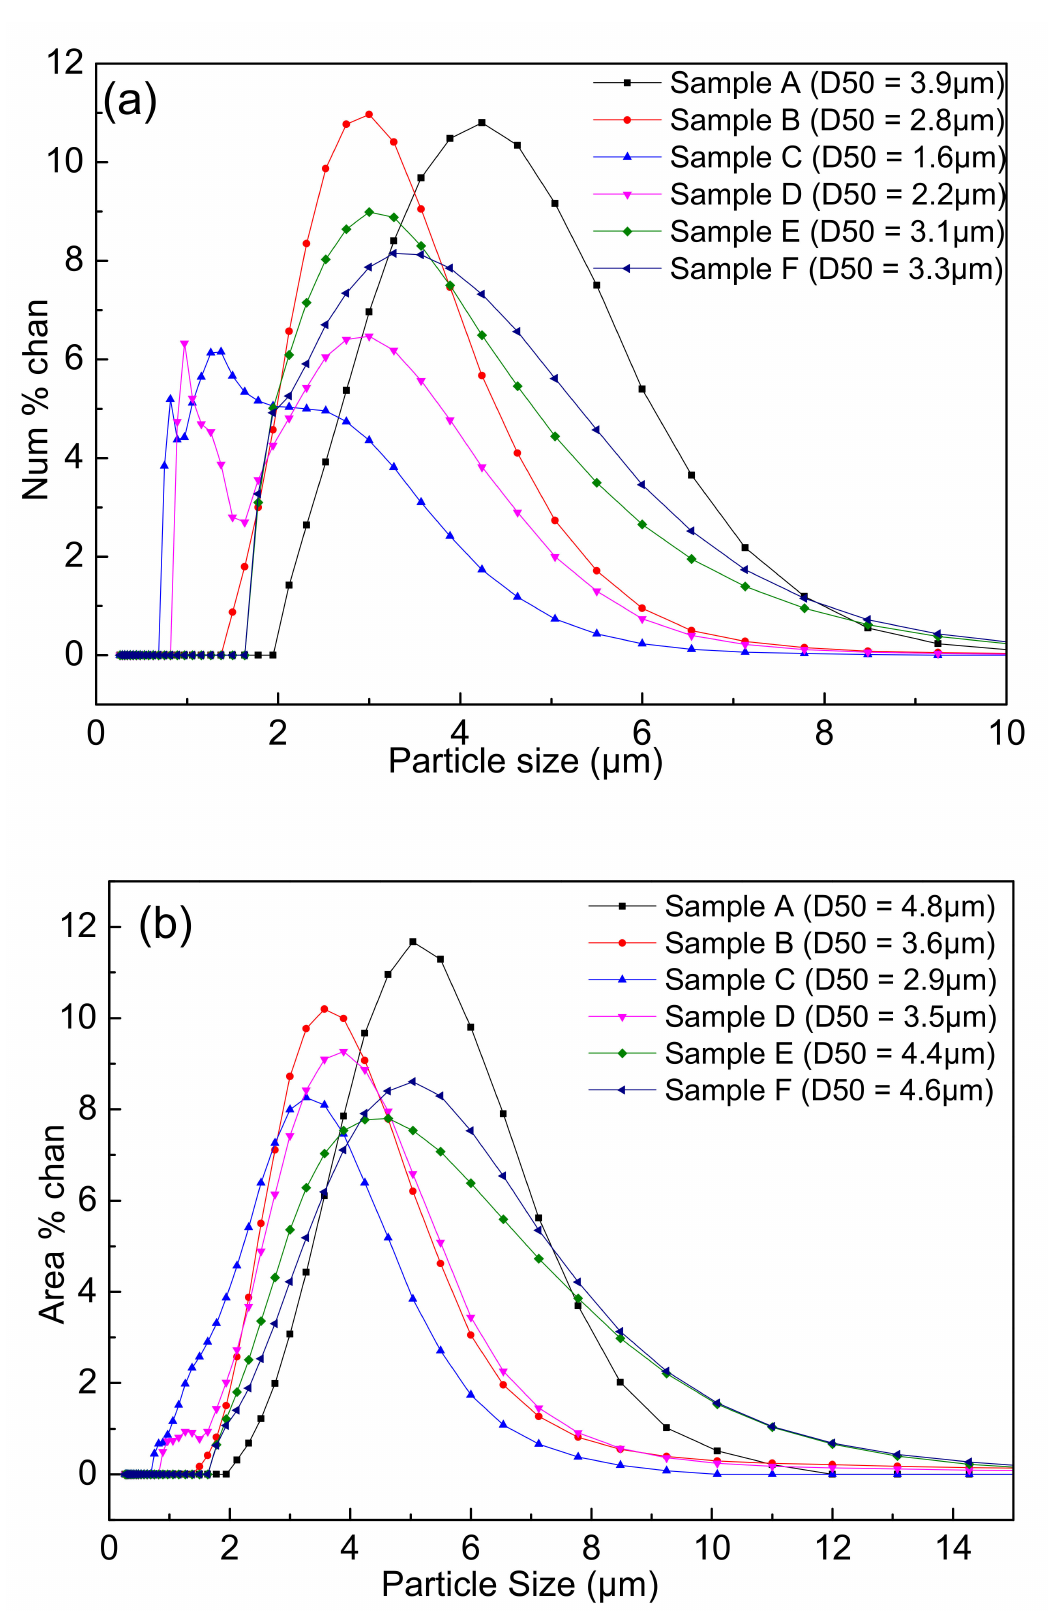
Figure 7. Particle size distributions of the nitridized powders with different PVB additions: ( a ) number distribution; and ( b ) area